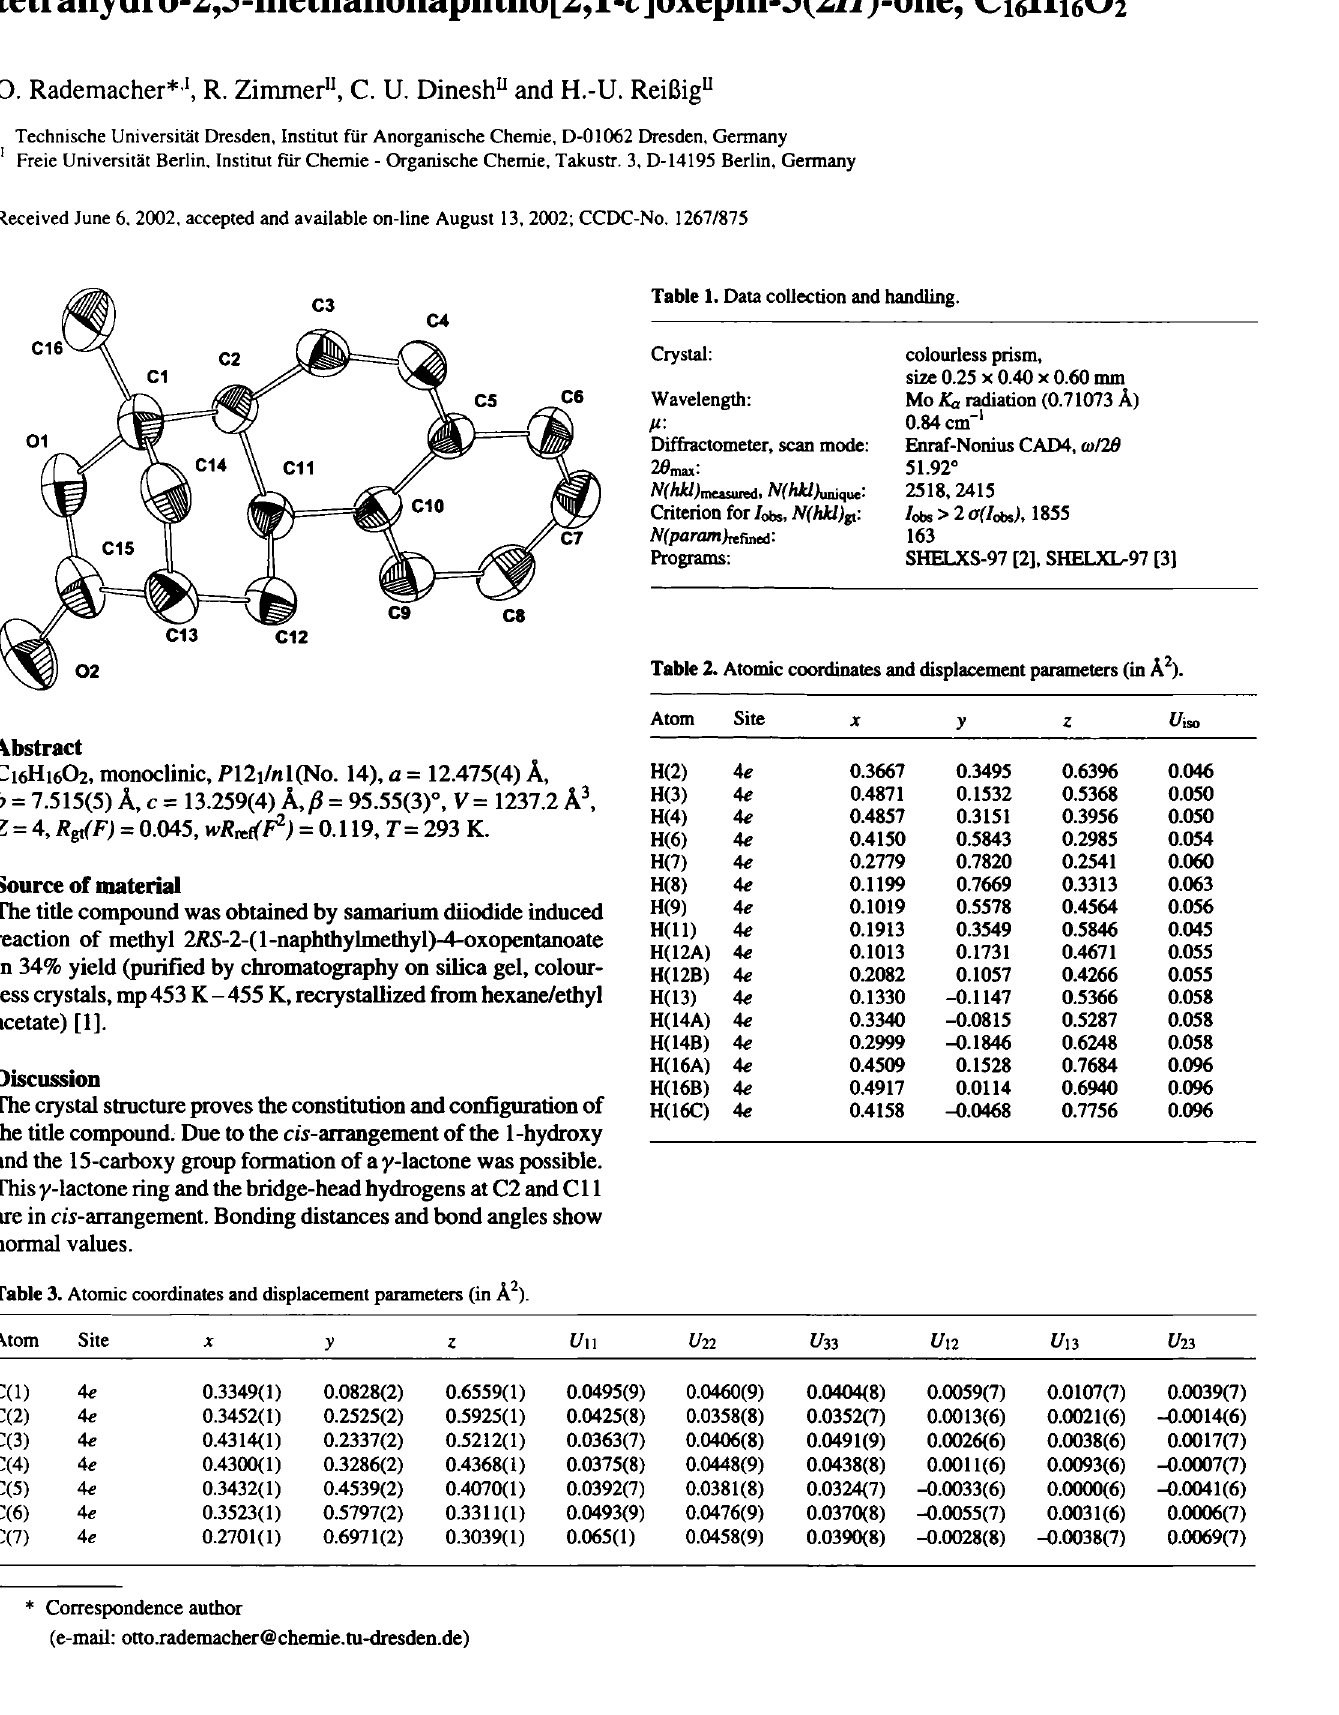
Table 1. Data collection and handling.